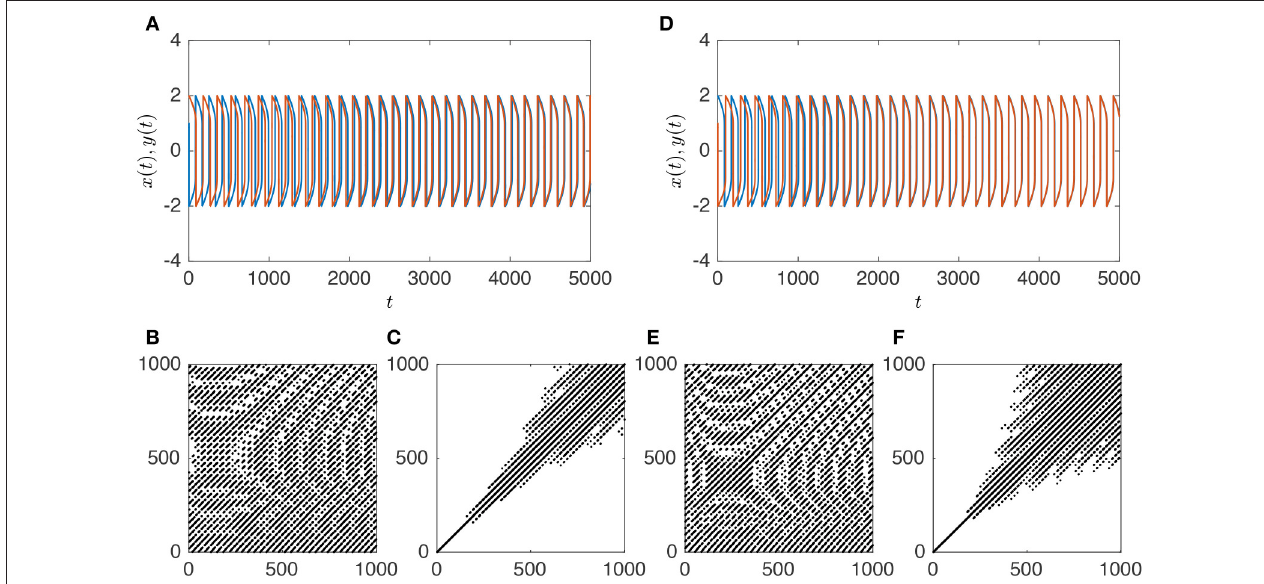
FIGURE 4 | Temporal dynamics (A) of a system of two (in red and blue) coupled van der Pol oscillators with ǫ 1 = 0.01. CRP (B) and MdRP (C) for the time series shown in (A) with D = 2, τ = 1, and T = 0.01 for both CRP and MdRP. (D–F) show the same, but for ǫ 1 = 0.02. In both cases ǫ 2 = 5 ǫ 1 .